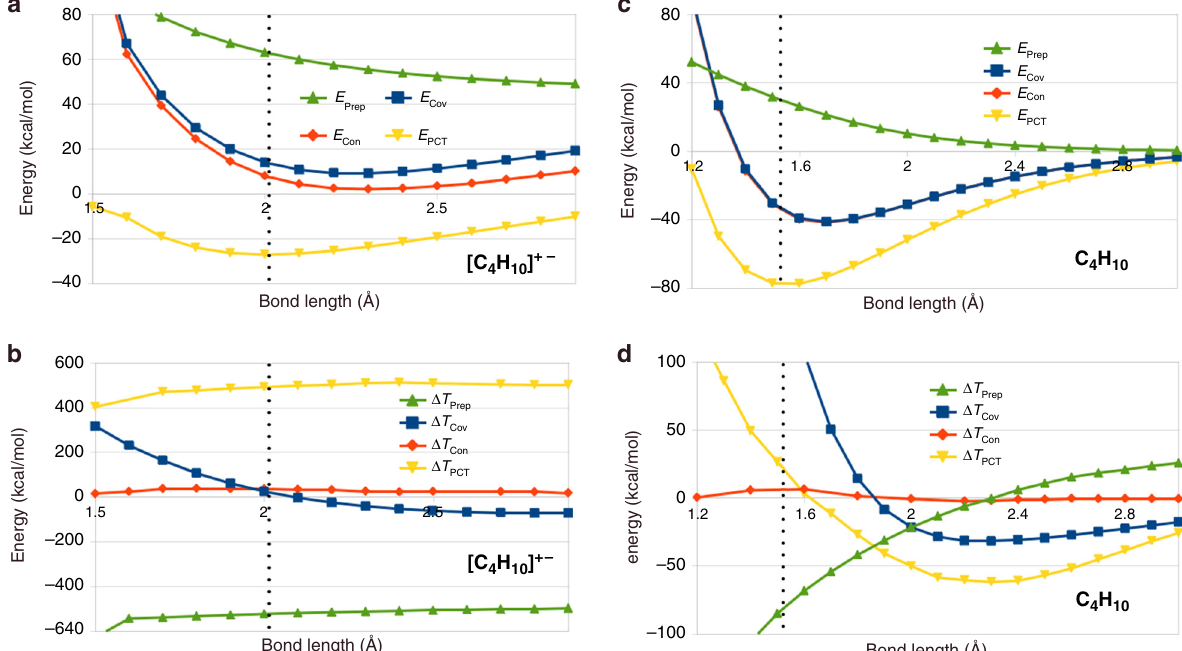
Fig. 2 Energy and kinetic energy changes for 1 and 2 e − C – C bonds. a Energy decomposition for relaxed dissociation of the central C – C bond in n -butane cation; energy terms are cumulative. b Kinetic energy decomposition for relaxed dissociation of the central C – C bond in n -butane cation; kinetic energy changes, Δ T , are increments. c Energy decomposition for relaxed dissociation of the central C – C bond in n -butane. d Kinetic energy decomposition for relaxed dissociation of the central C – C bond in n -butane. In n -butane, almost half the binding energy occurs due to covalent interaction, but is accompanied by a signi fi cant KE increase at the equilibrium geometry (vertical dots). In the weakly bound cation, the KE also increases slightly upon covalent coupling of the fragments at equilibrium. These results are in striking contrast to H þ and H 2 (see Fig. 2